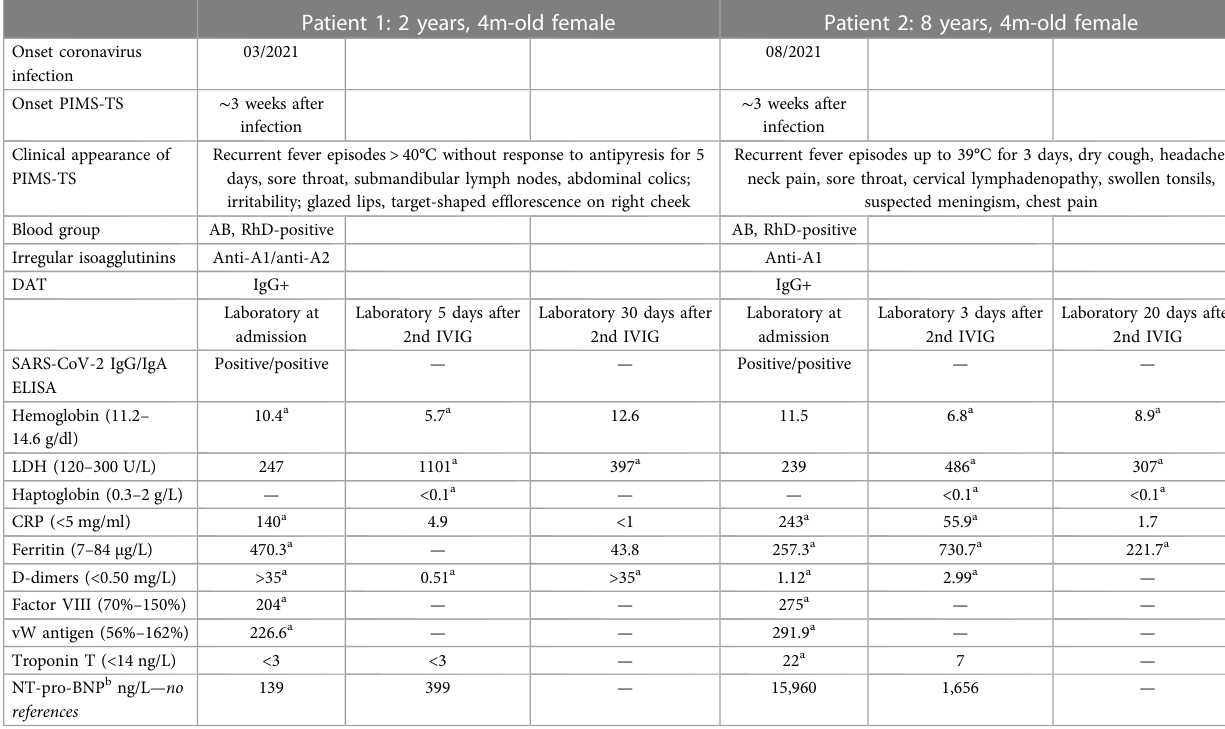
TABLE 1 Characteristics.